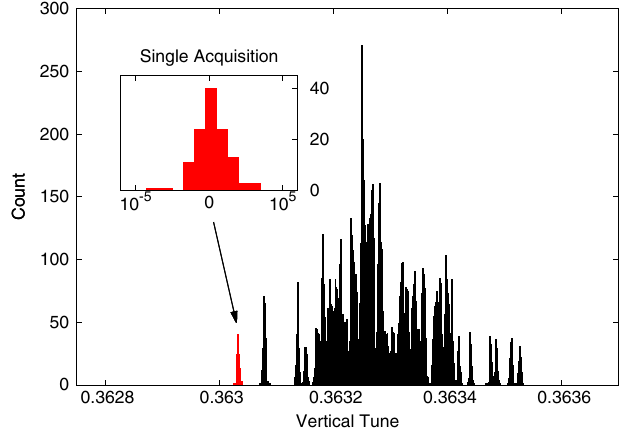
FIG. 3. Tune jitter measurement at ALBA. In a single acquis- ition, the rms tune spread over the 120 BPMs (in red) is only 2 × 10 − 6 , but this increases to 10 − 4 when the measurement is extended over 100 acquisitions due to the power supplies noise